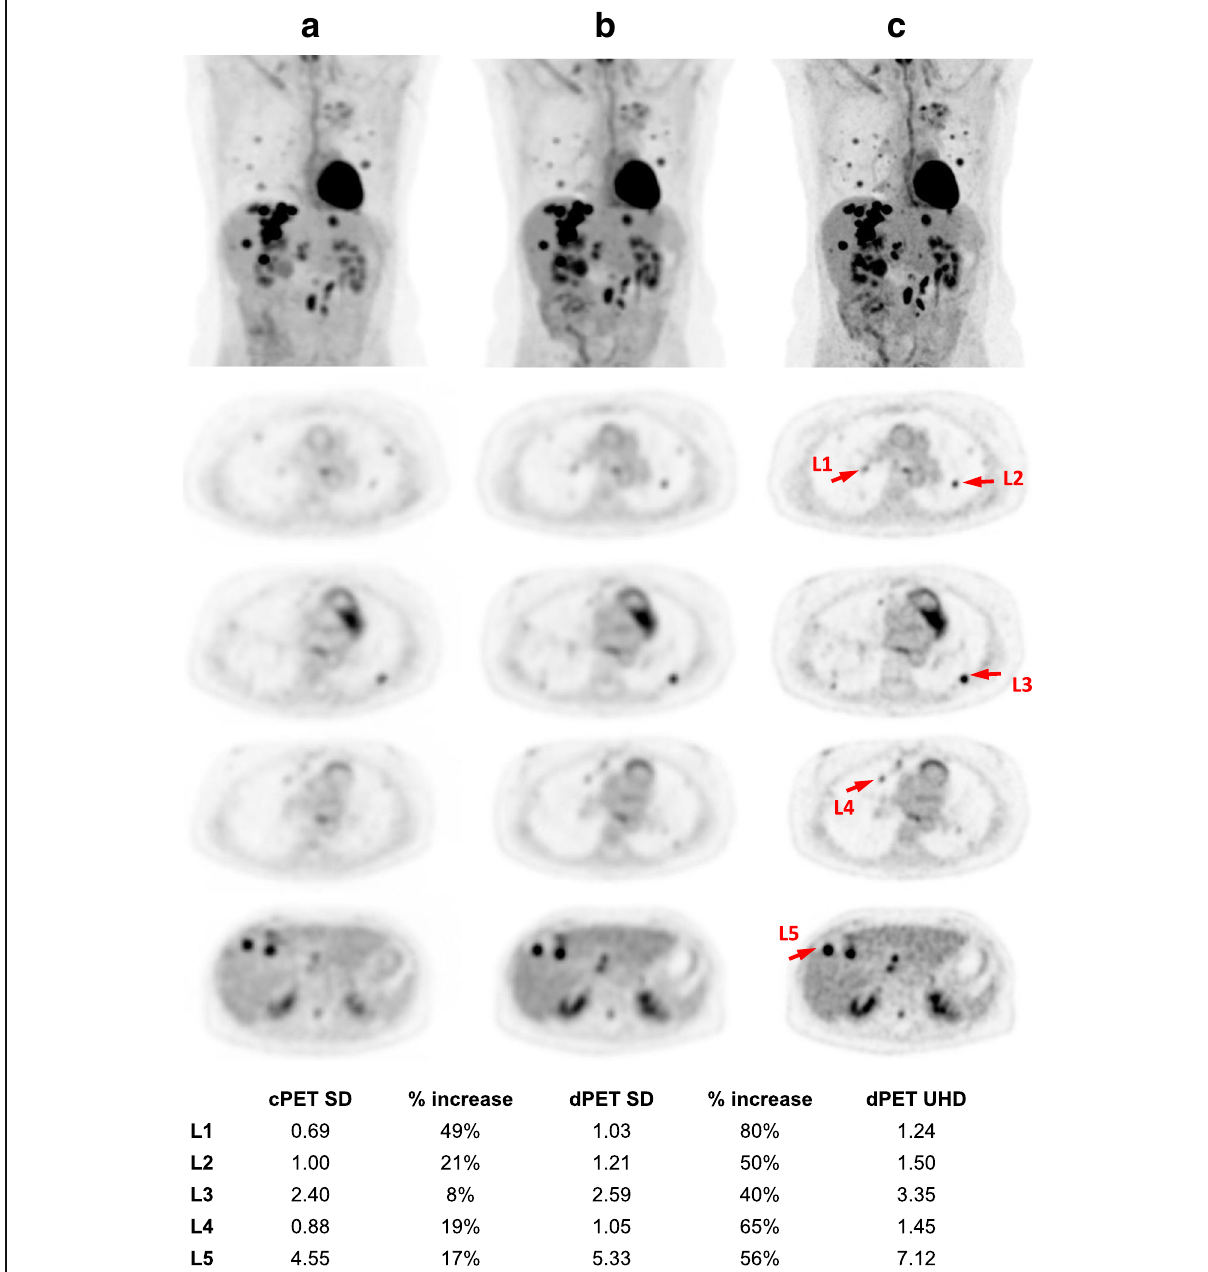
Fig. 9 Intra-individual comparison of a SD cPET (75 min p.i., 3i33s) with b SD dPET (103 min p.i., 3i15s) and c UHD dPET (103 min p.i., 3i13s) for a clinical patient with extensive metastatic disease in the lung and the liver (BMI = 18.5, 503 MBq FDG, 90 s/bed). Images were reconstructed using 3D OSEM TOF. The contrast of lesions is improved on SD dPET and prominently on UHD dPET compared to SD cPET. The lesion conspicuity and detectability as well as the diagnostic confidence for the pulmonary and hepatic lesions are classified by blinded reader analysis as substantially improved on dPET. It revealed an average of 23 ± 16% and 58 ± 15% higher SUV peak values for SD dPET and UHD dPET than SD cPET based on five representative lesions selected (pointed by red arrows),